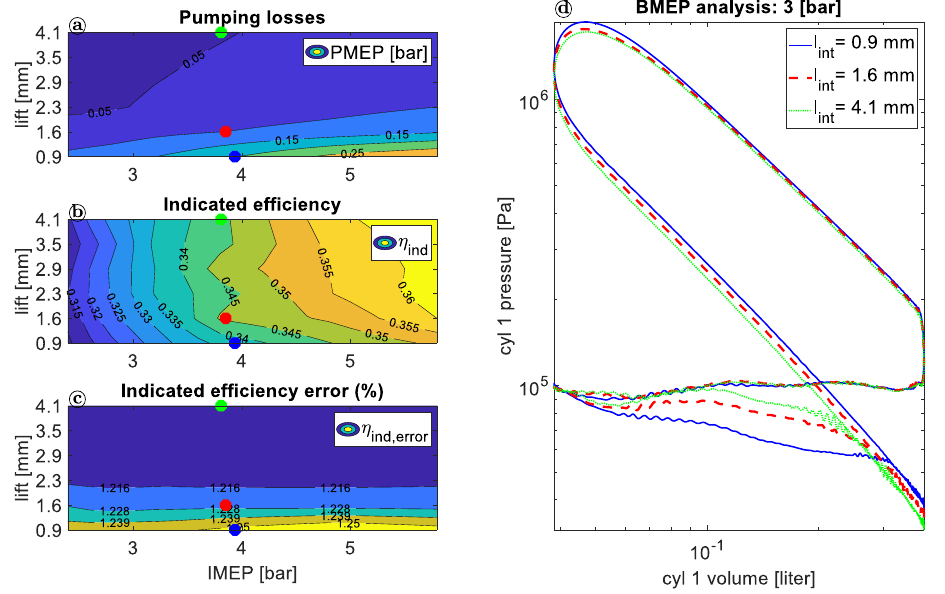
ffi ciency and pumping losses at an engine speed of 2000 min − Figure 4. Analysis of efficiency and pumping losses at an engine speed of 2000 min -1. Figure 4. Analysis of e